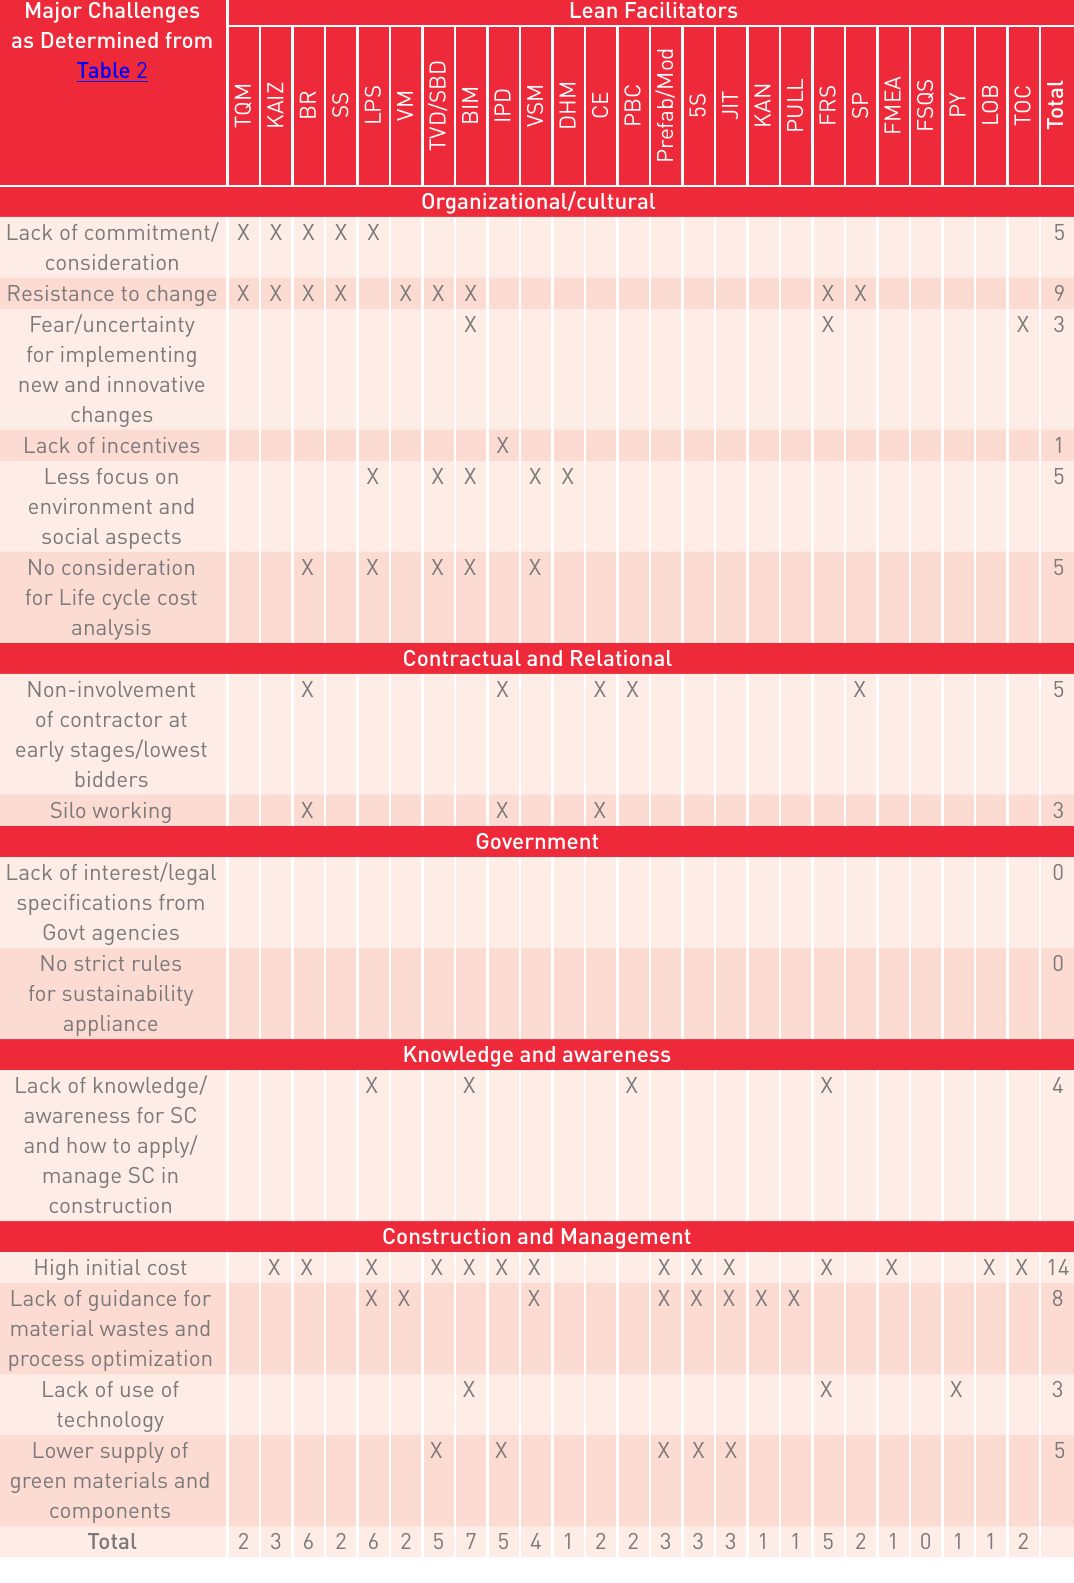
Table 4. The LAST matrix Major Challenges as Determined from Table 2